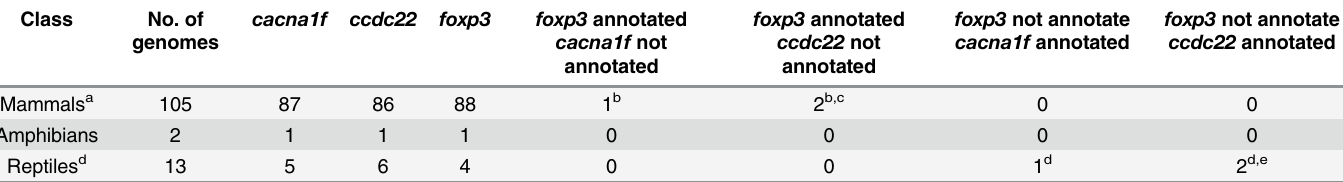
Table 1. The genomic conservation of foxp3 with its downstream flanking genes, cacna1f and ccdc22